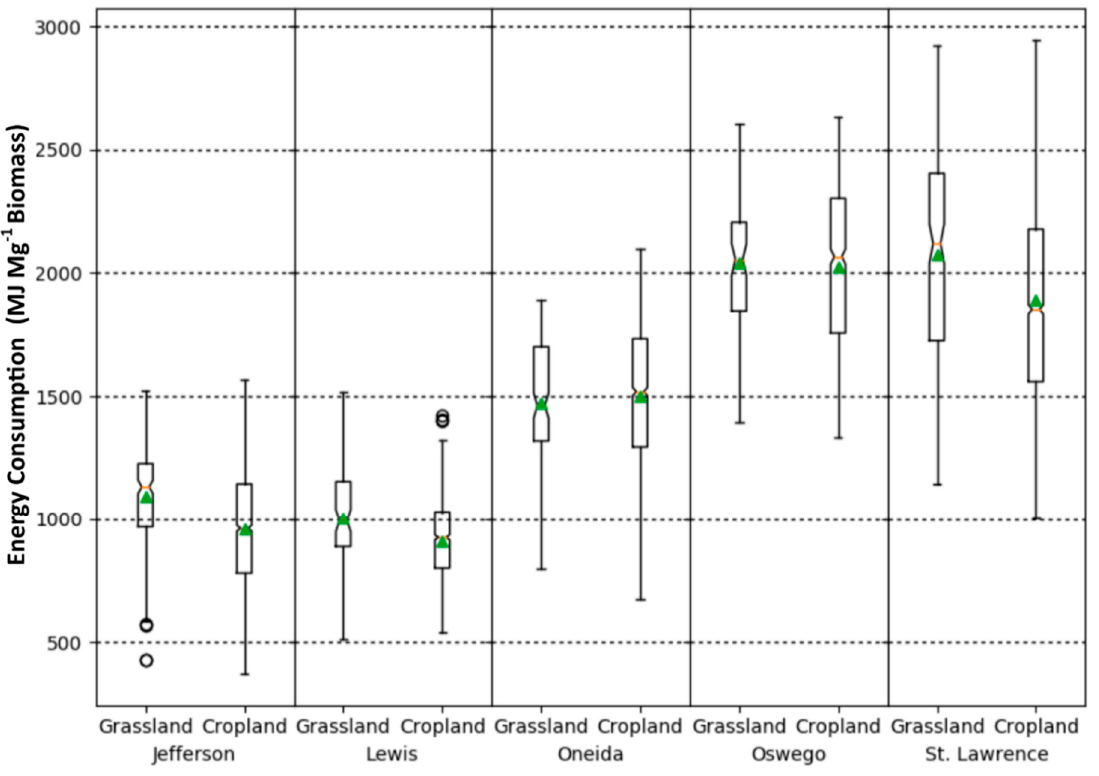
Figure 8. Boxplots of energy consumption to produce 1 Mg of willow biomass from parcel level LCA in five counties in central and northern NY. The upper and lower bounds of boxplots represent 75% and 25% quantiles, respectively. The notches represent median values and the triangles represent mean. For each county, the energy consumption is shown separately for grassland and cropland due to differences in yield and site preparation steps for the two land cover classes.